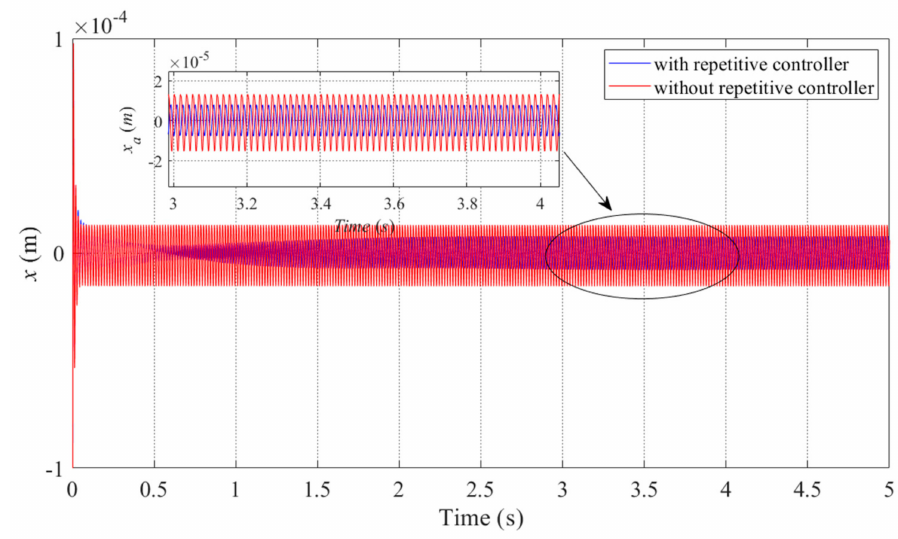
Figure 17. Trajectory of the rotor in x -direction with repetitive control (blue curve) and without repetitive control (red curve).